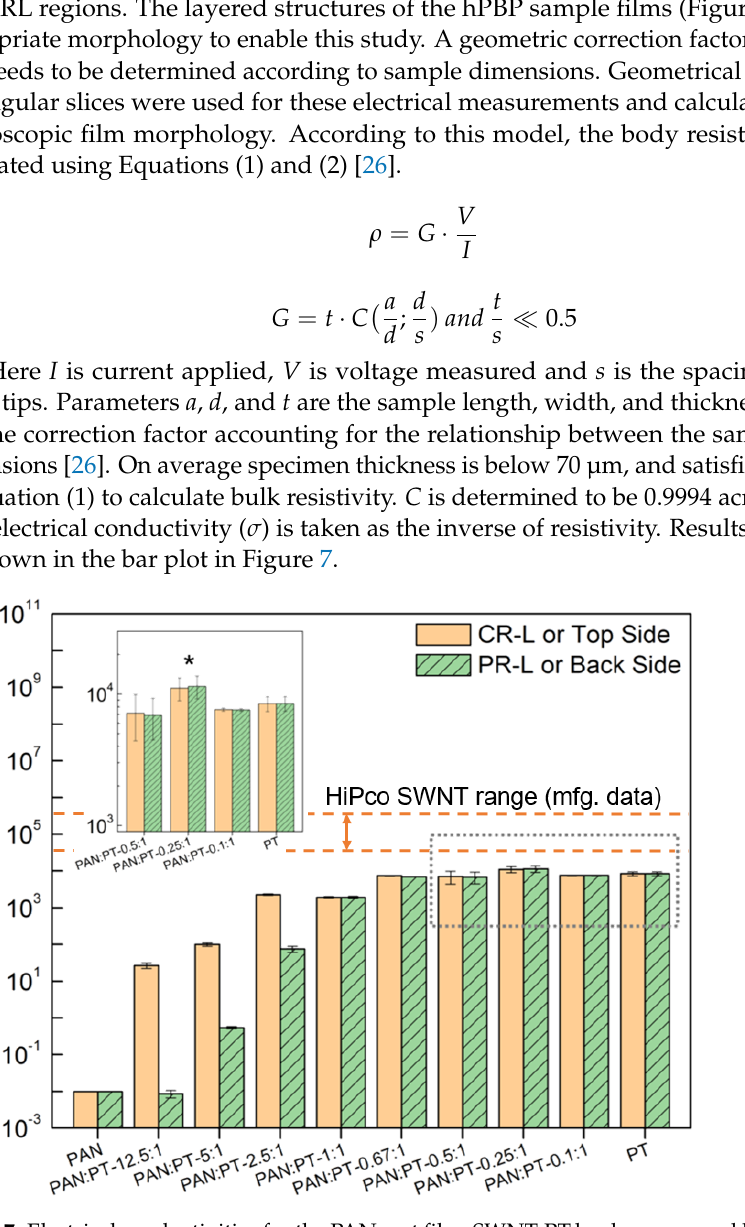
Figure 7. Electrical conductivities for the PAN cast film, SWNT-PT buckypaper, and hPBPs at different PAN:SWNT ratios. Properties are measured from both sides of all samples. The asterisk denotes the ideal loading ratio